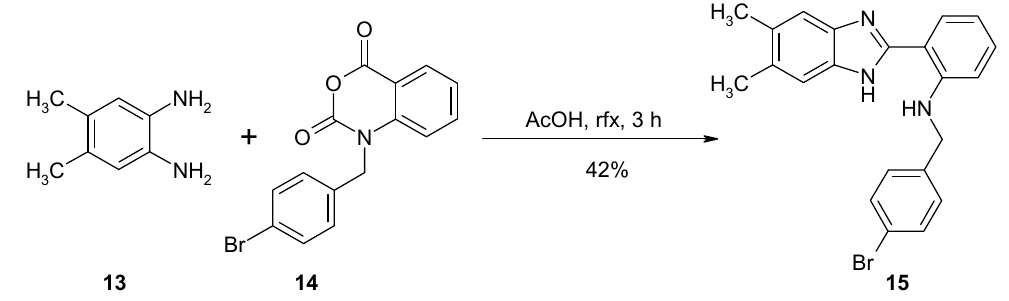
Figure 1. Molecular structure of 15 with crystallographic numbering. Displacement ellipsoids are drawn at the 50% probability level and the H-atoms are shown as small spheres of arbitrary radius. The intramolecular N–H···N hydrogen bond is represented by a dashed line.